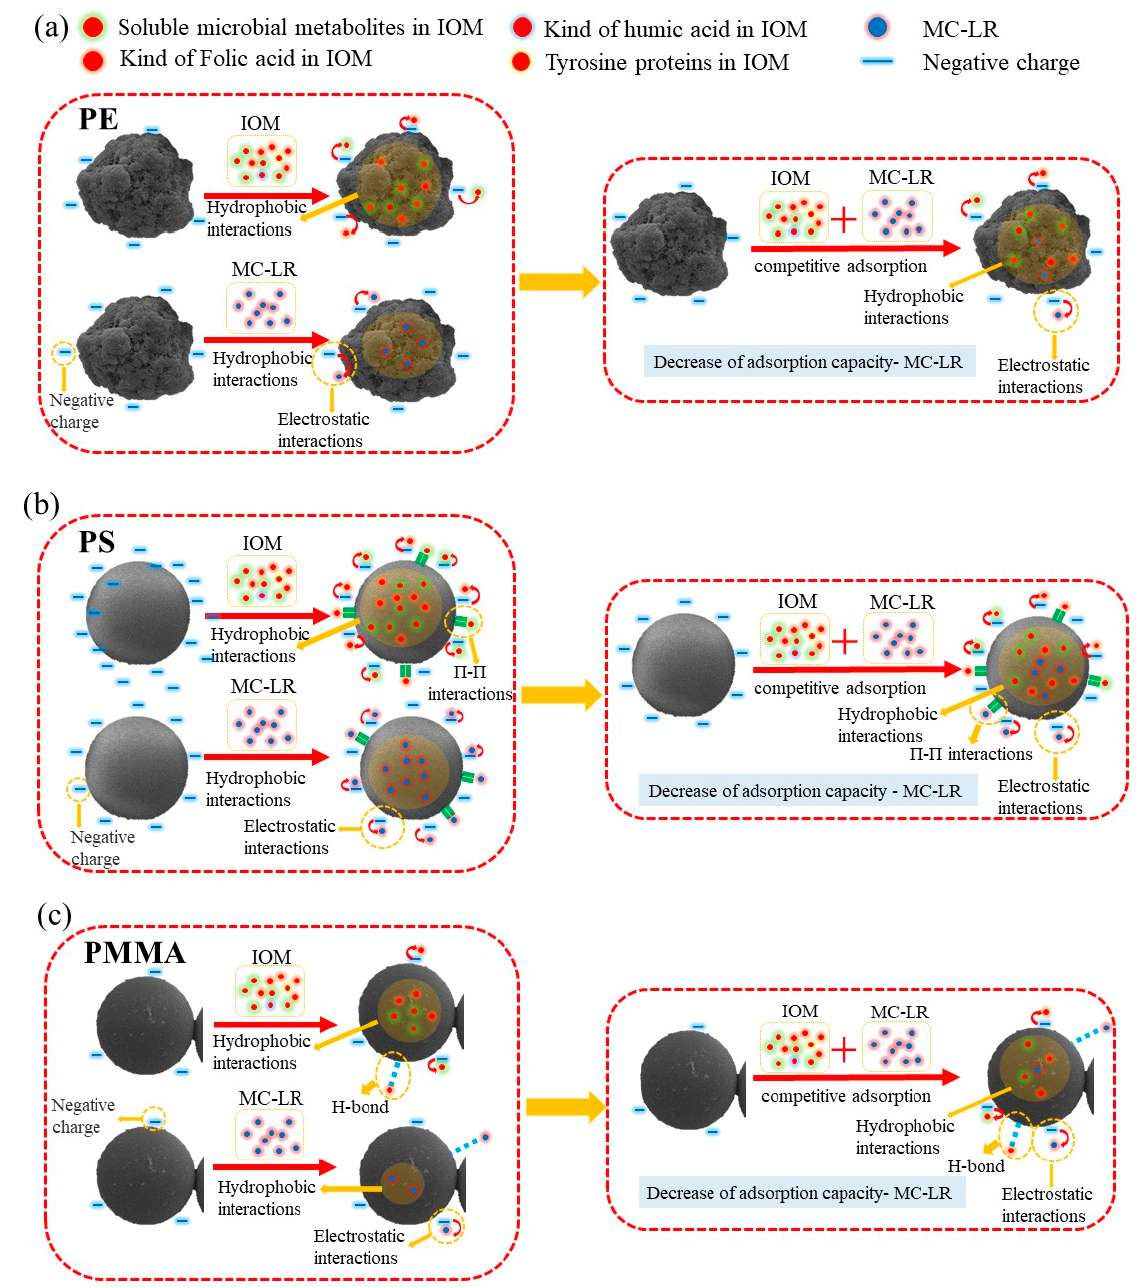
Figure 6. Conceptual schematic of PE ( a ), PS ( b ), and PMMA ( c ) adsorption of MC-LR and IOM, as well as the adsorption process of MC-LR in the presence of